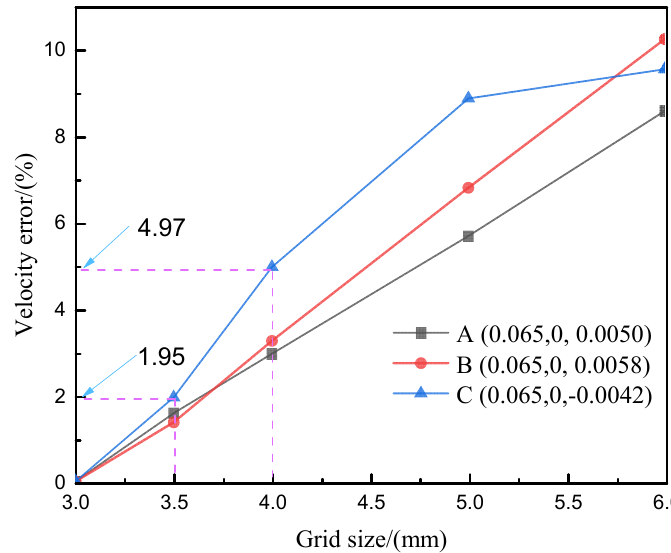
Figure 3. Radial velocity error under different grid density.